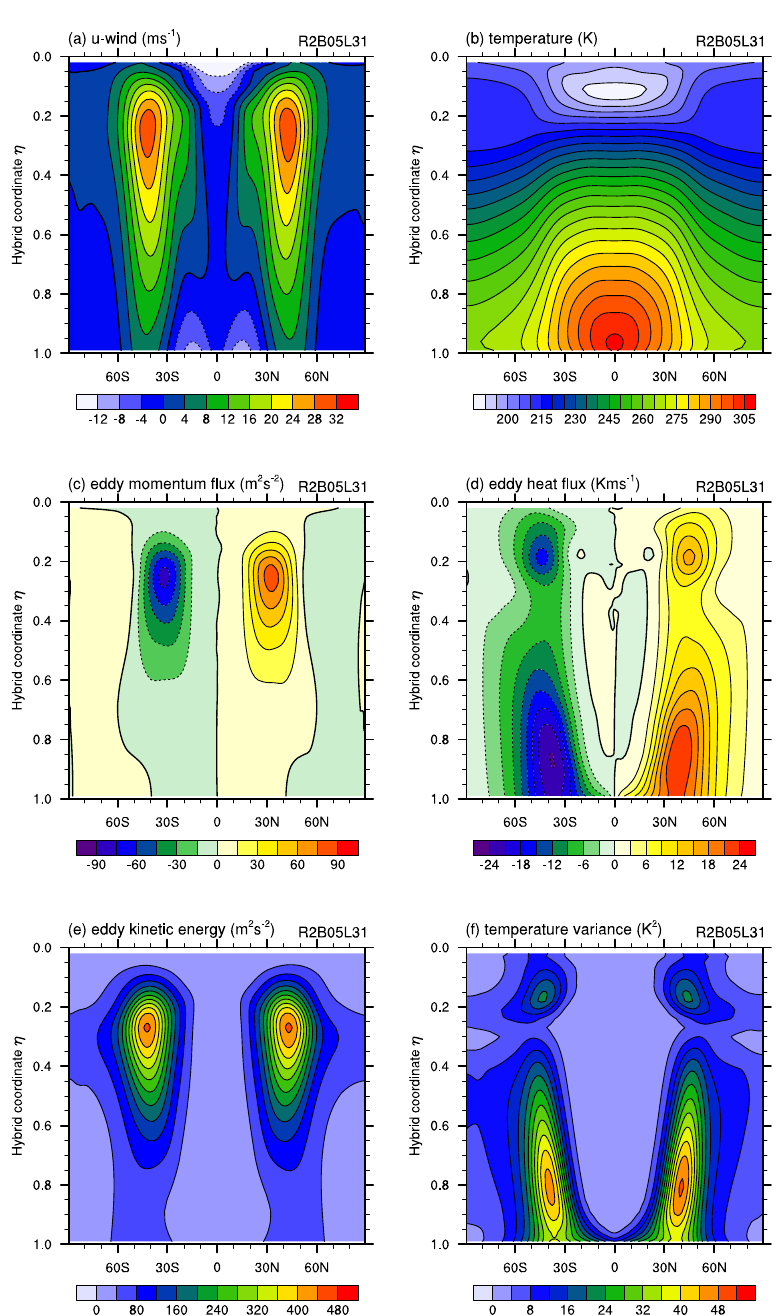
Fig. 11. Zonal mean climate state simulated by the ICOHDC in the Held–Suarez test at R2B5 resolution. The quantities shown are ensemble averages of 10independent integrations. Each ensemble member starts from the same initial condition but with random noise added to the wind field. Further details can be found in Sect.